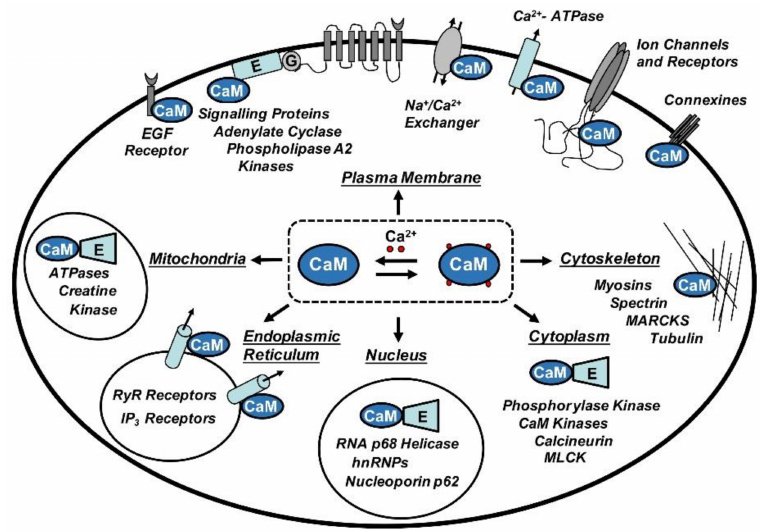
Figure 1. The central role played by calmodulin (CaM) in the regulation of a wide spectrum of binding partners. Abbreviations: hnRNPs: Heterogeneous nuclear ribonucleoproteins; MARCKS: Myristoylated alanine-rich C-kinase substrate; MLCK: Myosin light-chain